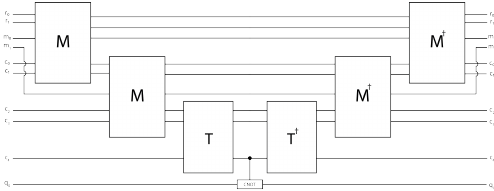
Figure 9. Schema of U ω with M and T operators for two moves. Given that we are working on finding the moves that determine the path of the robot while testing on the positions such moves